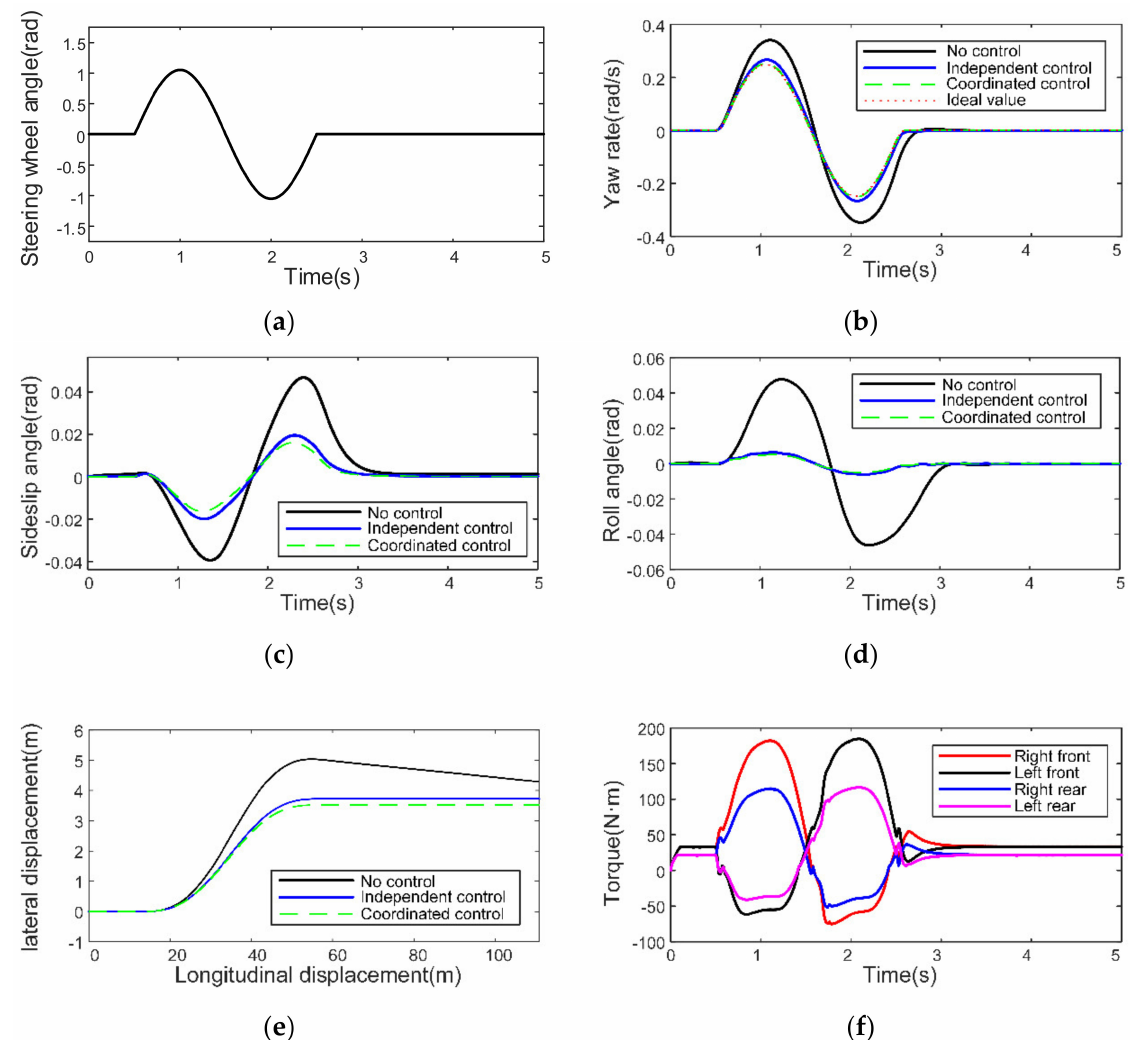
Figure 10. Stability performance under sinusoidal steering. ( a ) steering wheel angle; ( b ) yaw rate; ( c ) sideslip angle; ( d ) row angle; ( e ) vehicle trajectory; and ( f ) wheel